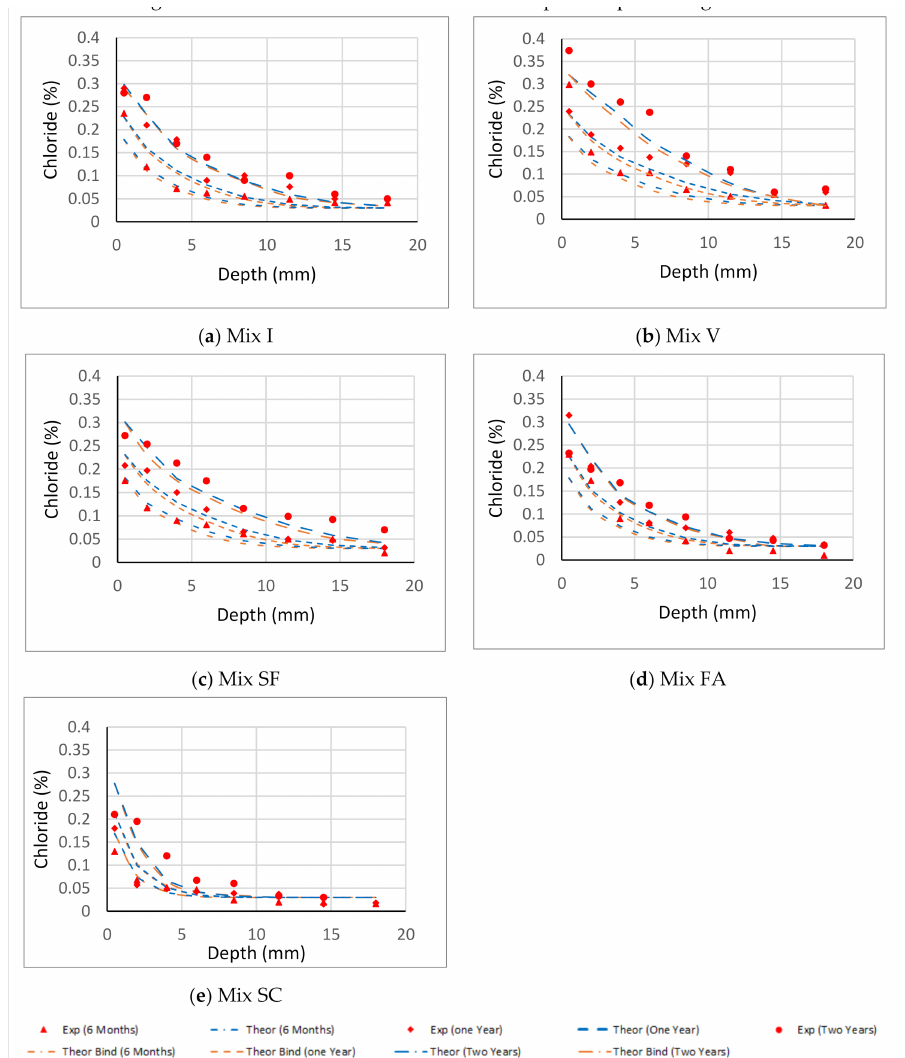
Figure 9. Chloride profiles for mixes in the tidal zone using the new binding model. ( a ) concrete with 100% ordinary Portland cement (OPC), ( b ) concrete with 100% type V cement (Sulfate resistance), ( c ) concrete with 6% silica fumes and 94% OPC, ( d ) concrete with 25% fly ash and 75% OPC, ( e ) concrete with 70% slag cement and 30%